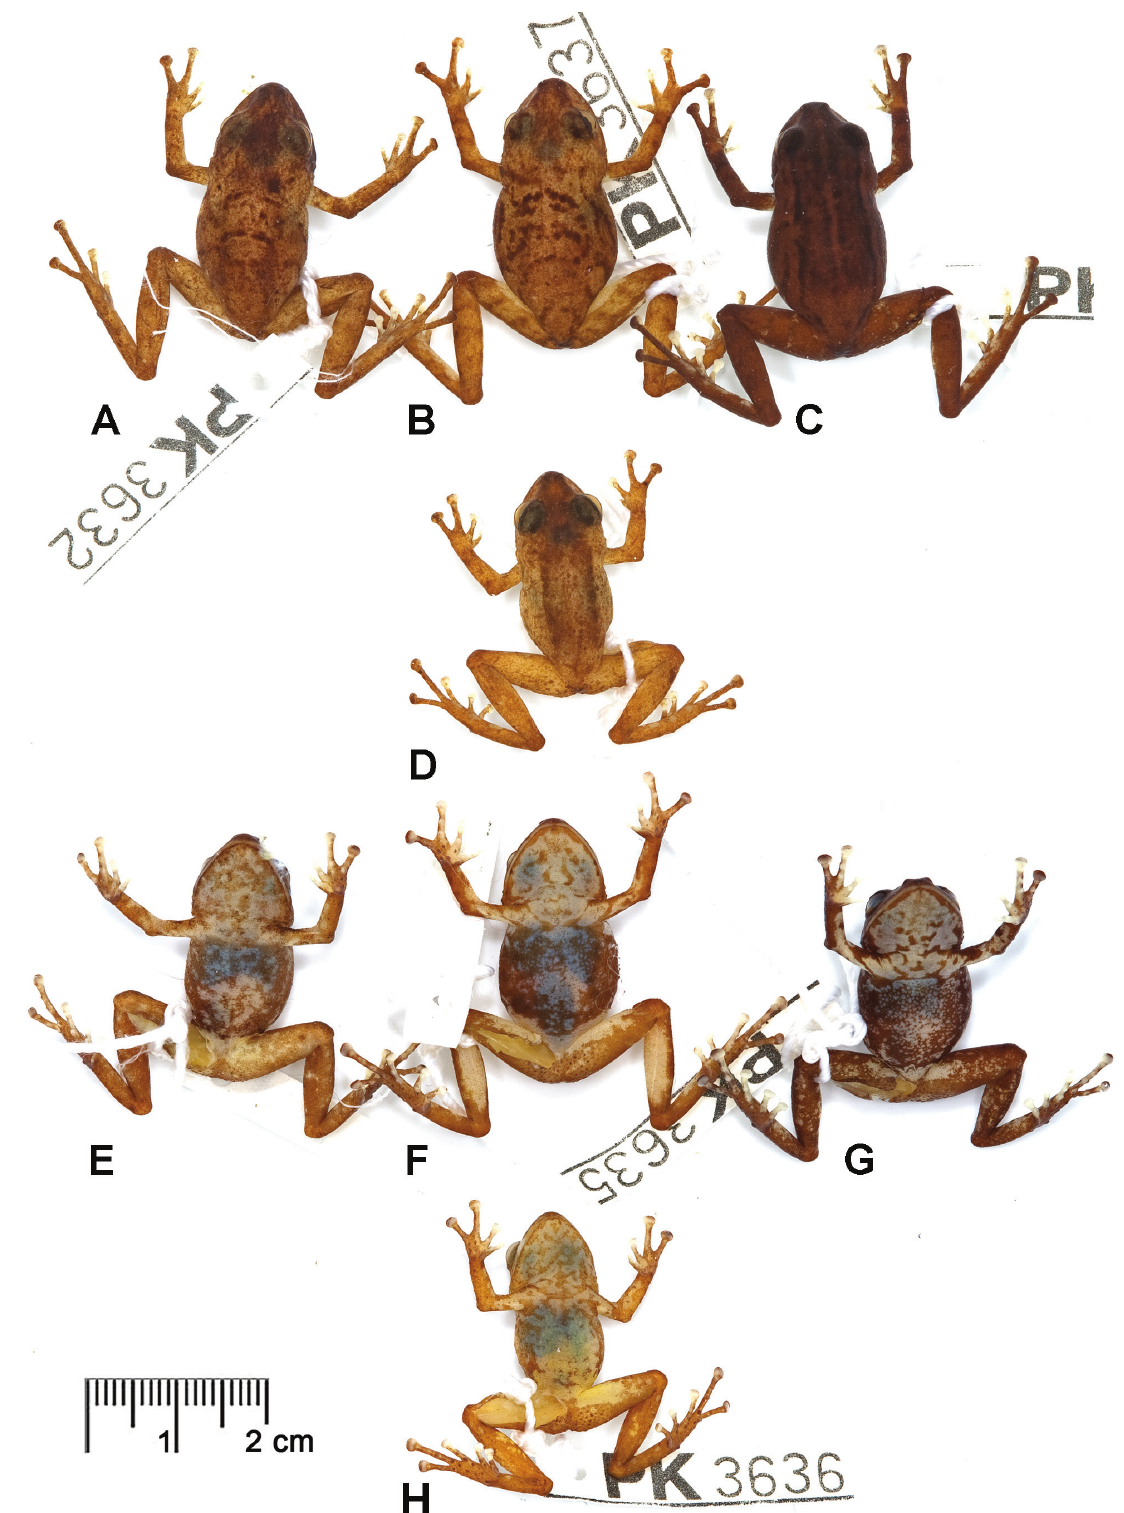
Fig. 4. Pristimantis jamescameroni sp. nov. Intraspecific variation in dorsal (above) and ventral (below) colour pattern in preserved specimens. A , E . ♀ paratype (IRSNB 4161). B , F . ♀ paratype (IRSNB 4162). C , G . ♀ paratype (IRSNB 4163). D , H . ♂ holotype (IRSNB 4160). Photographs by the